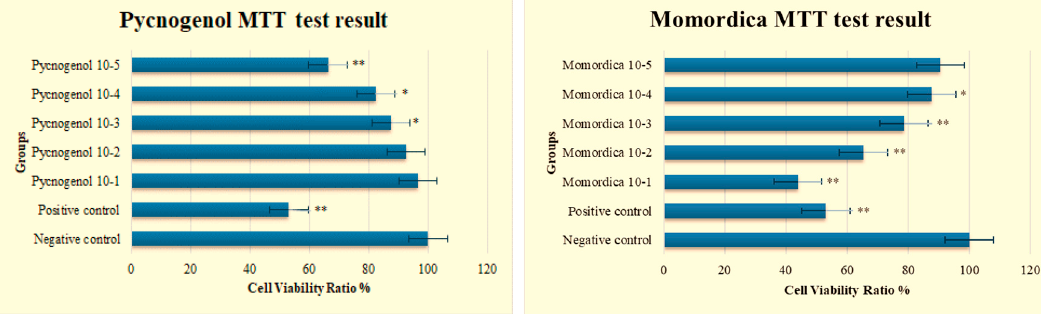
Figure 1. In vitro viability ratio of pycnogenol and momordica protective effect on induced imazamox toxicity effect on fibroblast cells ( n = 6/group) were shown. * Significant differences at p < 0.05 compared to control group; ** Significant differences at the p < 0.001 compared to control